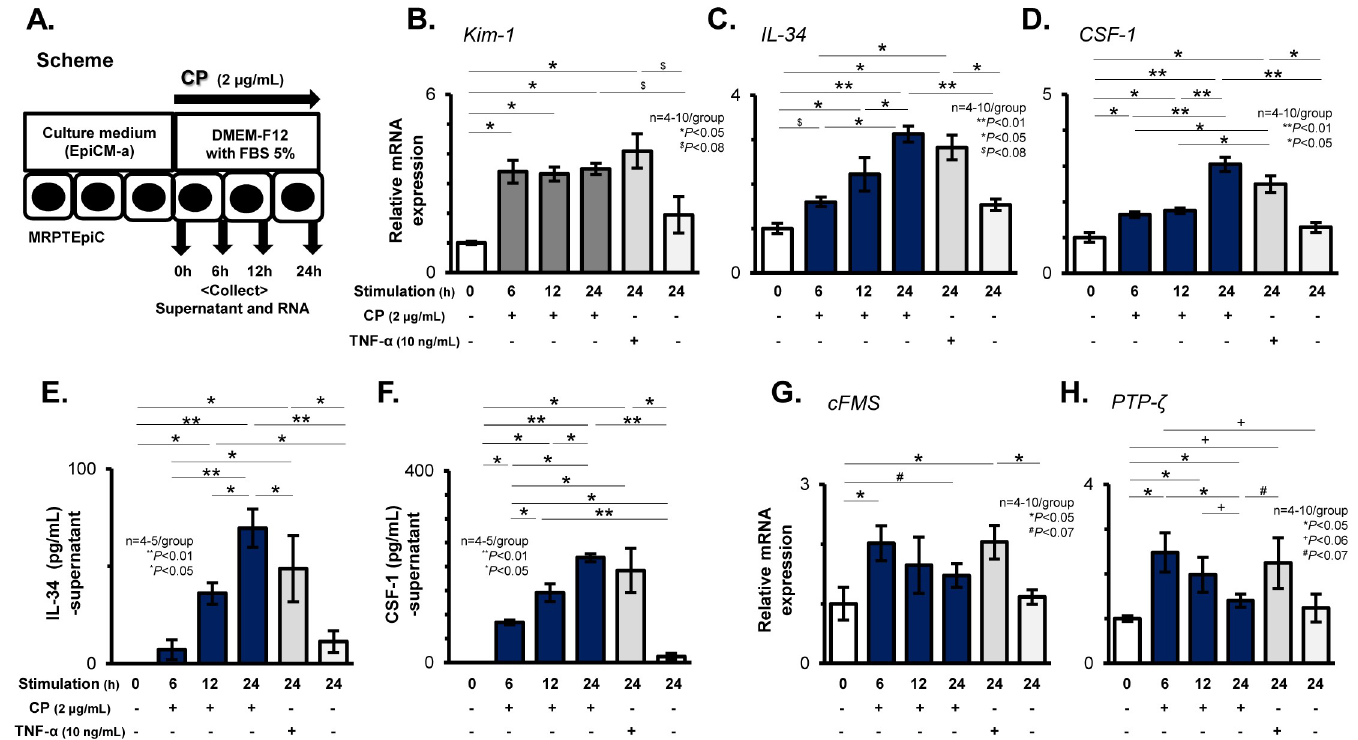
Fig 1. Expression of IL-34 and its two receptors on CP-stimulated MRPTEpiC. Scheme for the in vitro analysis using cultured MRPTEpiC stimulated with CP ( A ). MRPTEpiC and the culture supernatants were harvested after stimulation with CP (2 μ g/mL) for 0 to 24 h. Real-time RT-PCR for Kim-1 ( B ), IL-34 ( C ), and CSF-1 ( D ) in MRPTEpiC after stimulation with CP or TNF- α for 0 to 24 h. IL-34 and CSF-1 protein levels evaluated by ELISA in the culture supernatants of MRPTEpiC after stimulation with CP or TNF- α for 0 to 24 h ( E and F ). Real-time RT-PCR for cFMS ( G ) and PTP- z ( H ) in MRPTEpiC after stimulation with CP or TNF- α for 0 to 24 h. In the analysis of real-time RT-PCR, the values were normalized to the β -actin transcript, and are expressed as a relative ratio. Data are expressed as the mean ± SEM. The Mann-Whitney U test was used for statistical analysis.